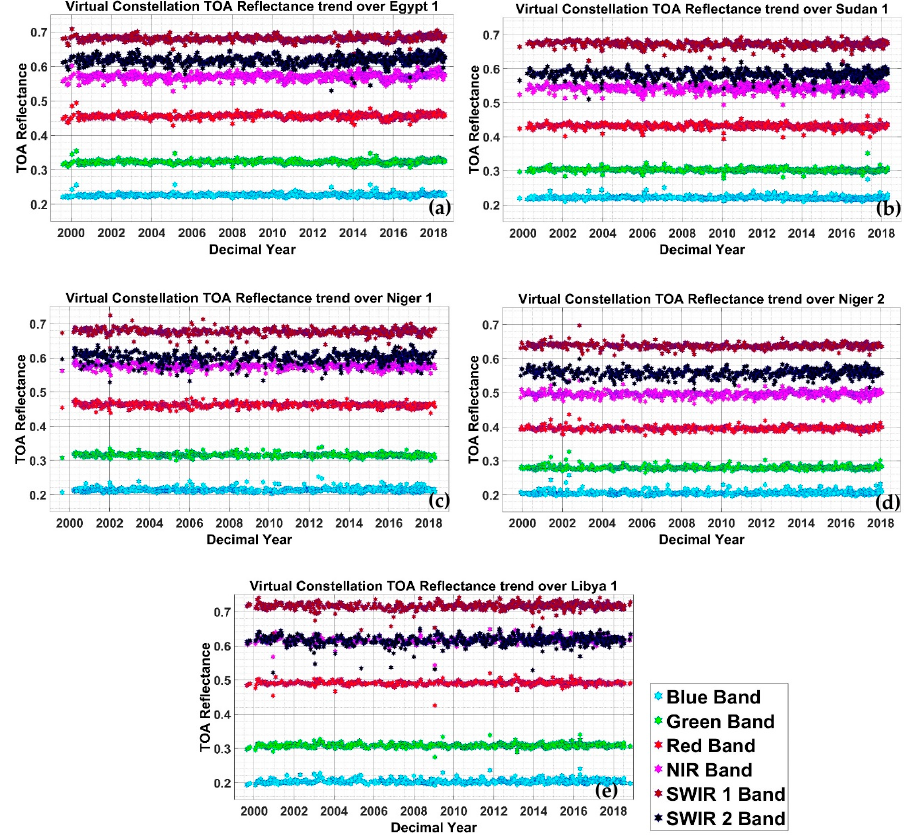
Figure 7. Homogenized TOA reflectance trends of Egypt 1 ( a ), Sudan 1 ( b ), Niger 1( c ), Niger 2 ( d ) and Libya 1( e ) PICS.